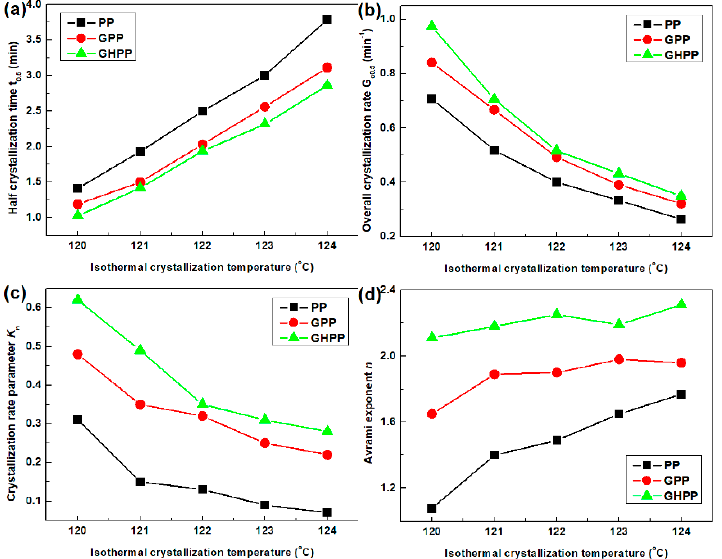
Figure 6. ( a ) Half crystallization time for overall crystallization, t o0.5 , ( b ) overall crystallization rate parameter, G o0.5 , ( c ) crystallization rate parameter involving both nucleation and crystal growth, k n , and ( d ) Avrami exponent n of samples as a function of isothermal crystallization temperature.